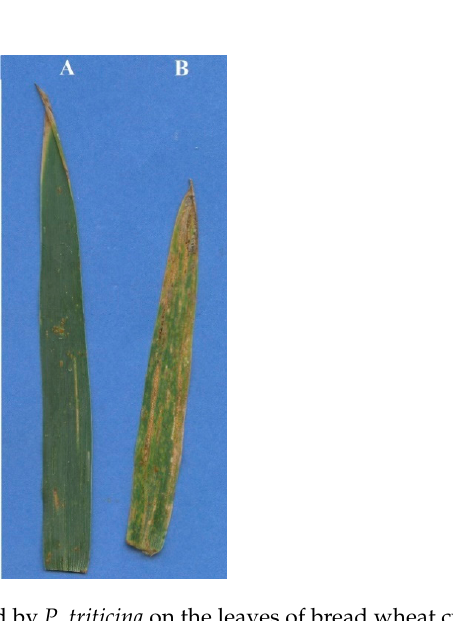
Figure 3. Symptoms of leaf rust caused by P . triticina on the leaves of bread wheat cv. Torka ( A ) and spelt-wheat line 18 ′ (S13 × T) ( B ). 3.2. Identification of Pm Resistance Genes